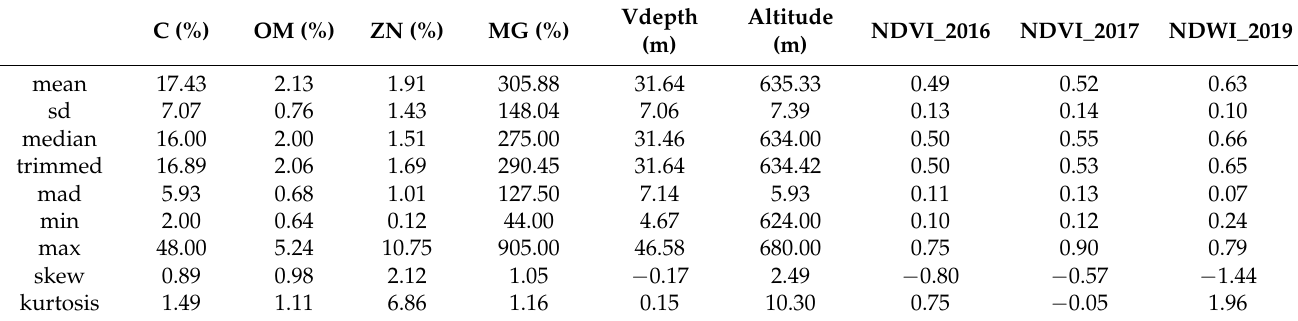
Table 2. Descriptive statistics of the auxiliary variables from the 403 locations in study area.